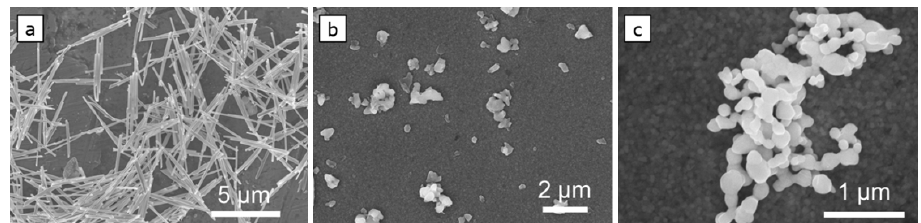
Figure 1. Scanning electron microscope (SEM) views of (a) synthesized tellurium needles, (b) 2 vanadium dioxide particles, and (c) silver particles. 3